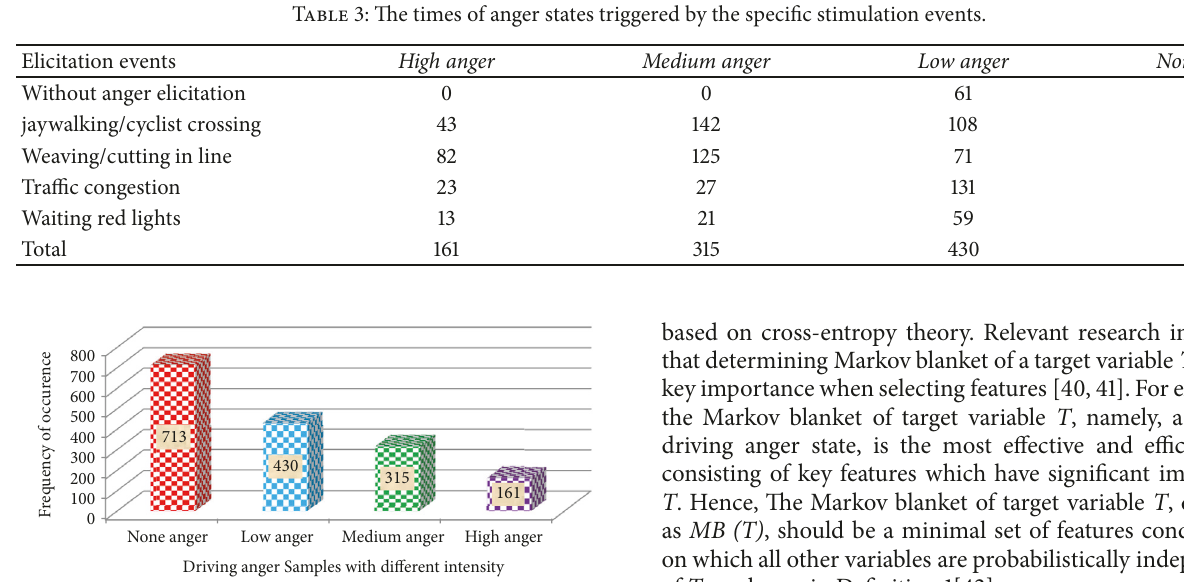
Figure 3: The number of different anger